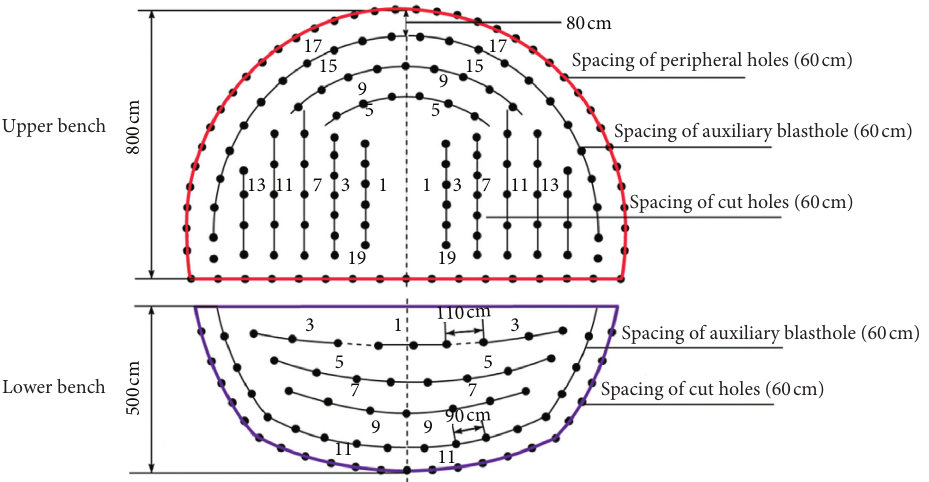
Figure 2: Blasting design of diversion tunnel #4 in the Jinping II hydropower